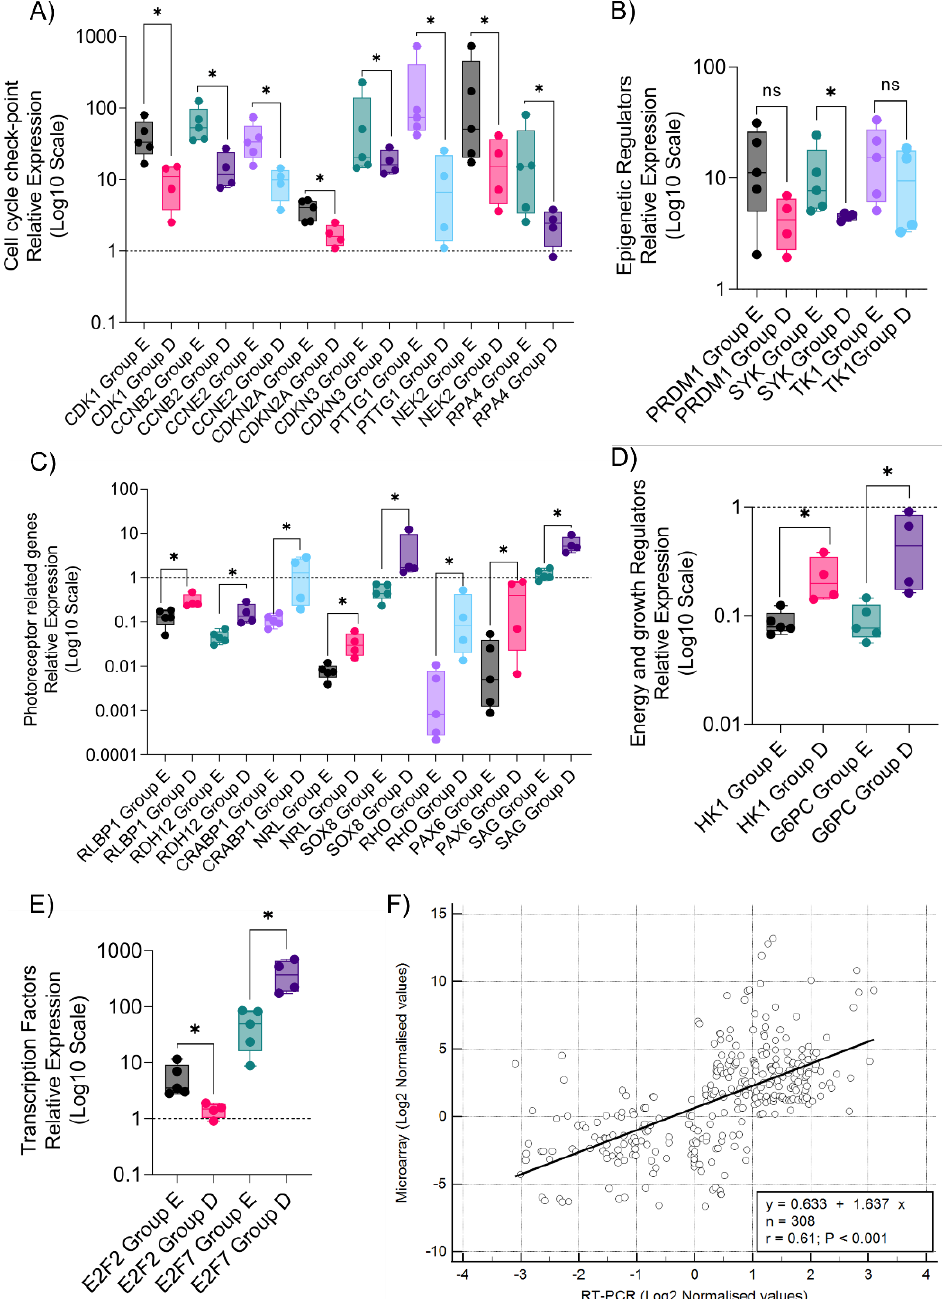
Figure 3. Validation of selected genes for mRNA expression in retinoblastoma subtypes. RT-PCR validation of microarray-identified targets ( A ) Cell cycle checkpoint genes. ( B ) Epigenetic regulators. ( C ) Photoreceptor-specific genes. ( D ) Energy and growth regulator genes. ( E ) Transcription factor genes. ( F ) Pearson correlation plot between microarray and RT-PCR expression of genes involved in cell cycle checkpoint, epigenetic regulation, photoreceptor-specific, energy regulation, and transcription factors. Values represent mean ± SEM. Unpaired two-sided Student’s t -test was used for statistical analysis. * p < 0.05, ns = no significance.